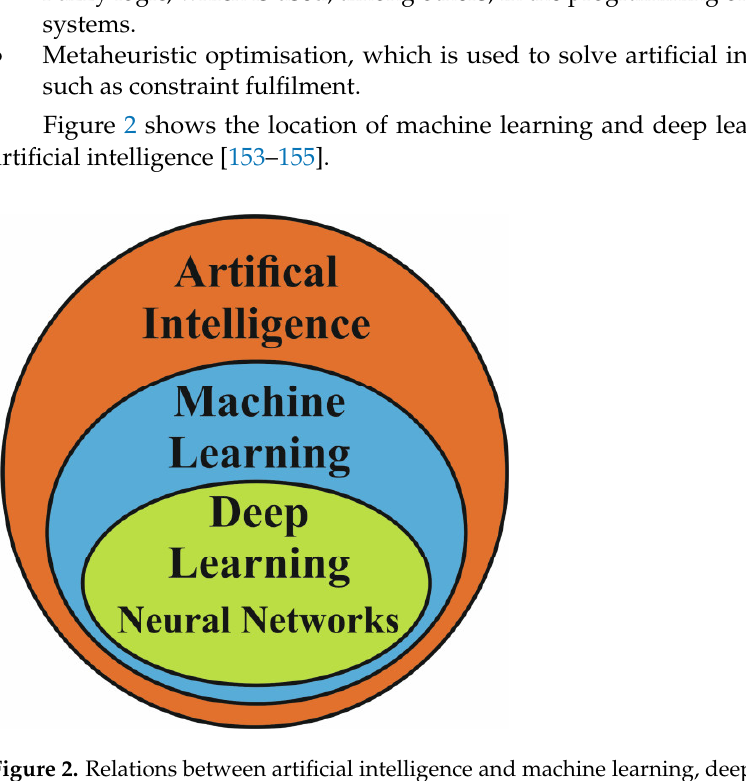
Figure 2. Relations between artificial intelligence and machine learning, deep learning and artificial neural networks [153–155].